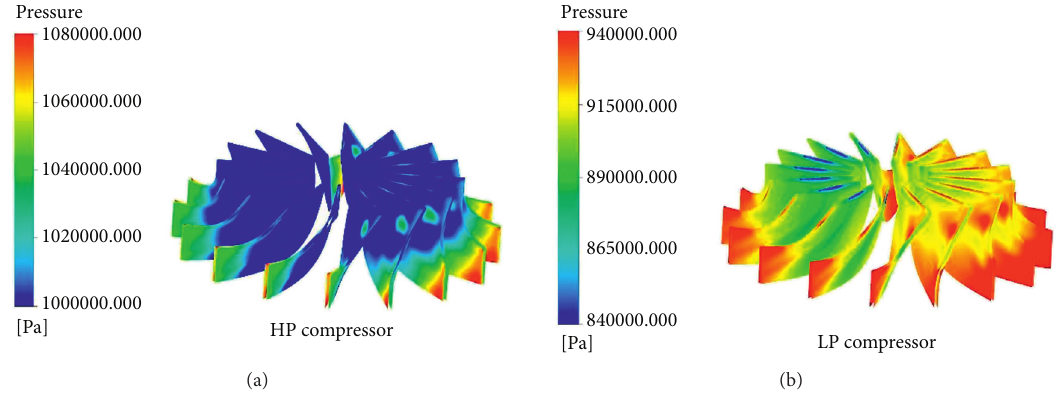
Figure 11: Contour of pressure for (a) HP Compressor (b) LP Compressor.